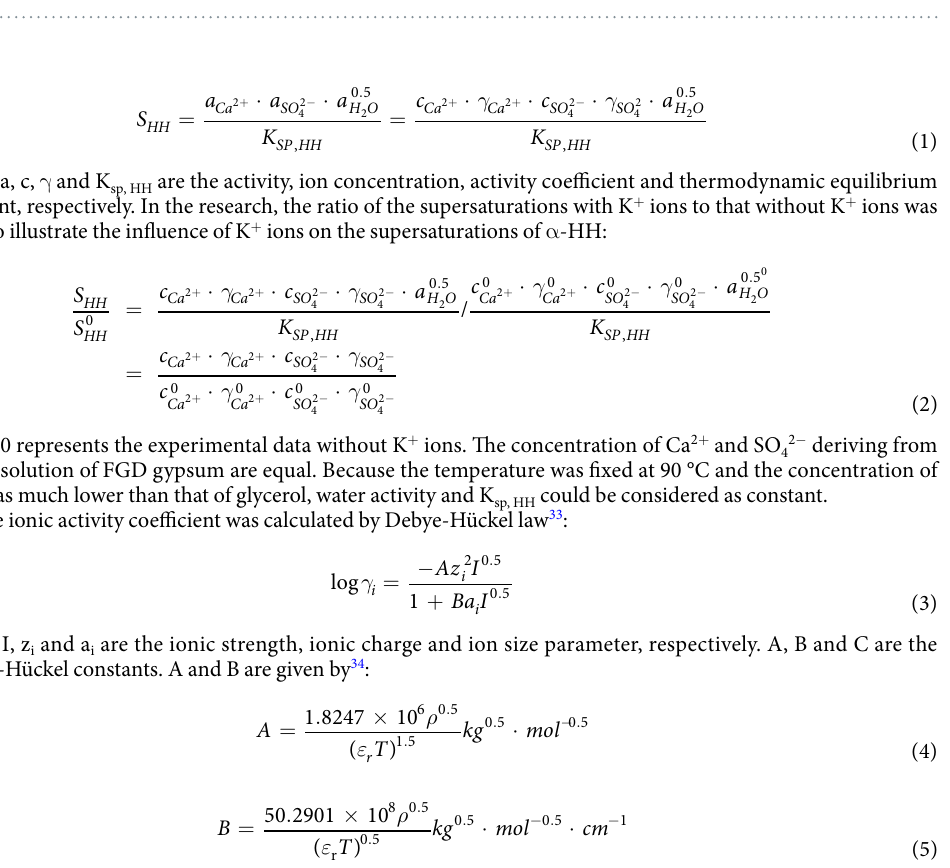
Figure 2. Influence of KCl on the time of phase transformation from FGD gypsum to α -HH in glycerol (65 wt%)-water solutions with different KCl concentration at 90